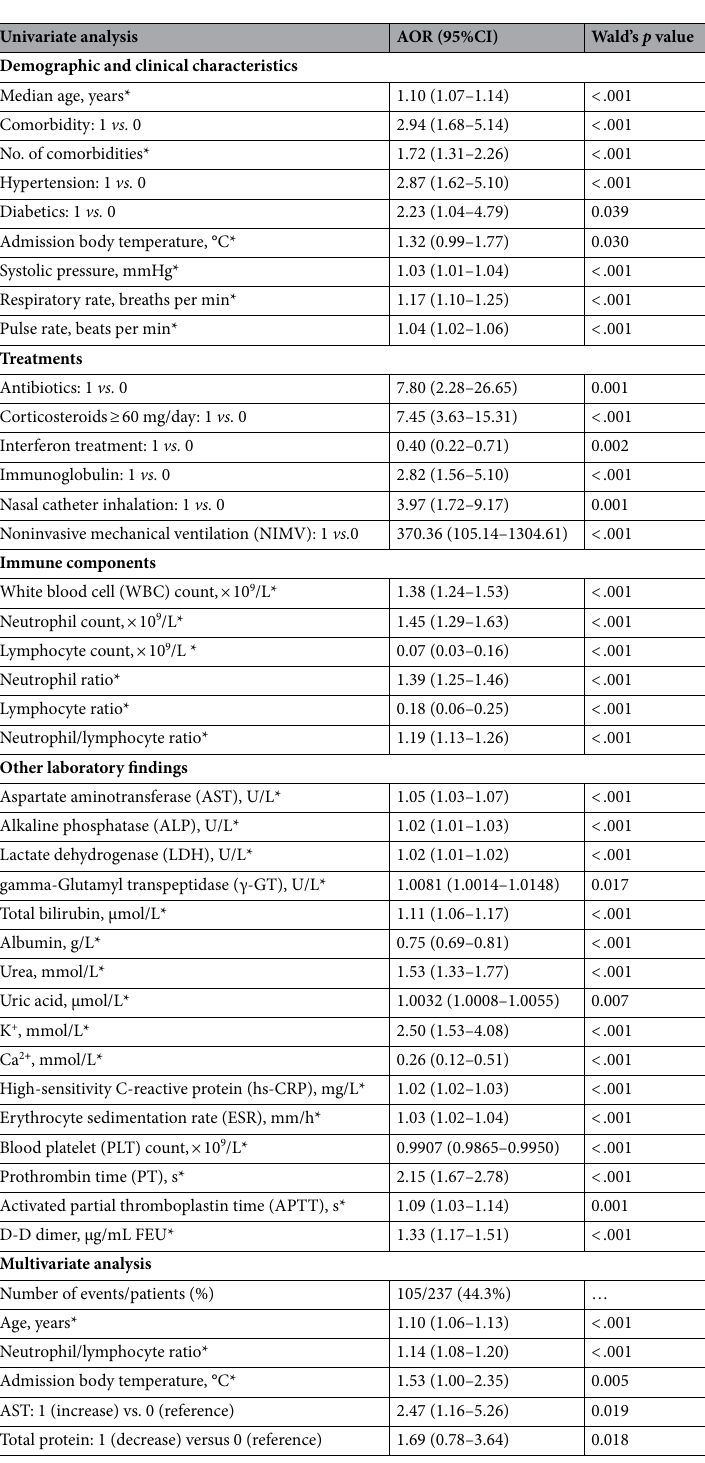
Table 2. Risk factors associated with mortality of COVID-19. *Continous variable; AOR Adjusted odds ratio, CI Confidence